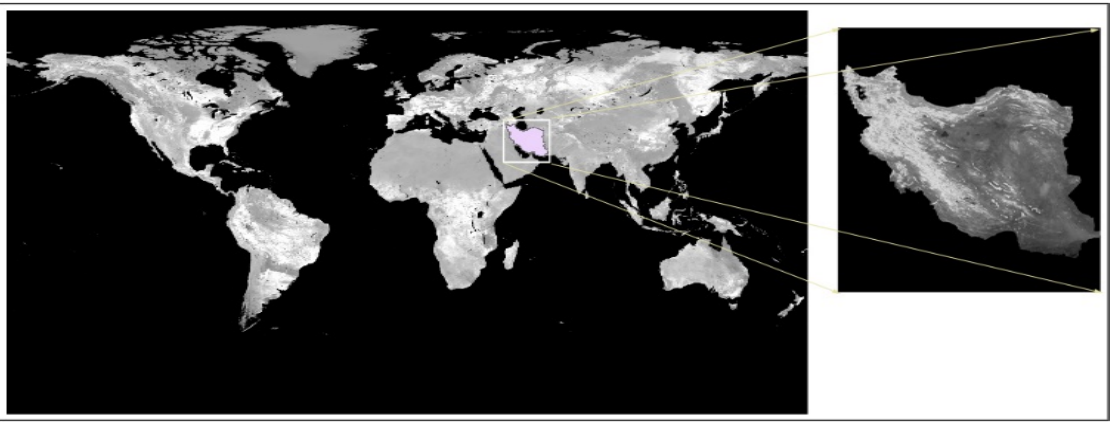
Figure 6. Monthly global NOAA NDVI for May 2014 and area of study (Iran). Downloaded product through: https://earthexplorer.usgs.gov/ (accessed on 19 July 2020). In order to carry out a statistical analysis, monthly NDVI averages during the period Table 3. Hazard quantification for the Sistan & Baloochestan Province